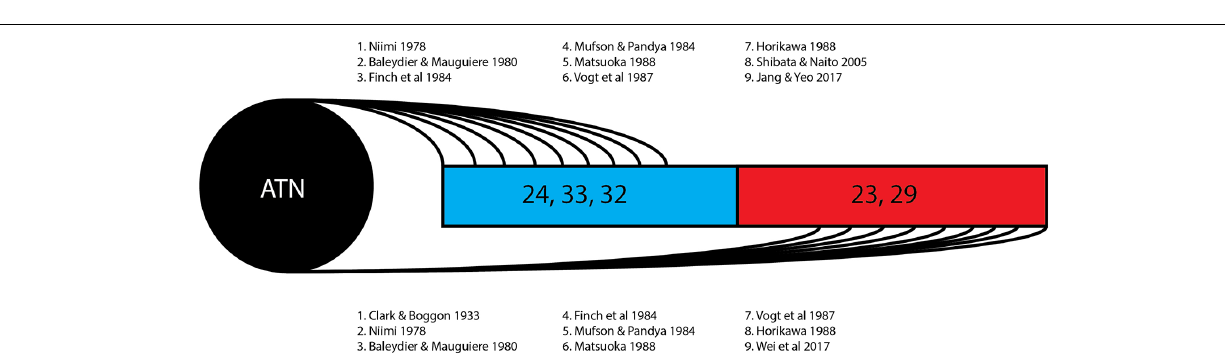
FIGURE 3 | Thalamocingulate tract termination in cingulum. Diagrammatic overview of the quantity of studies showing regions of thalamic termination once enclosed within the cingulum bundle. Brodmann area 24, 33, and 32 (shown in blue) correspond to the anterior cingulate cortex. Brodmann area 23 and 29 (shown in red) correspond to the posterior cingulate cortex and retrosplenial cortex. ATN, anterior thalamic